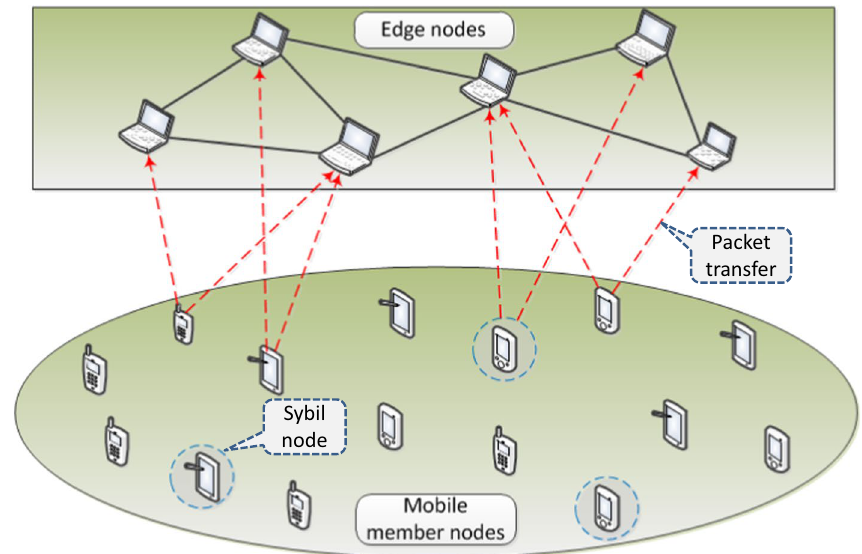
Fig. 1 Schematic diagram of Sybil